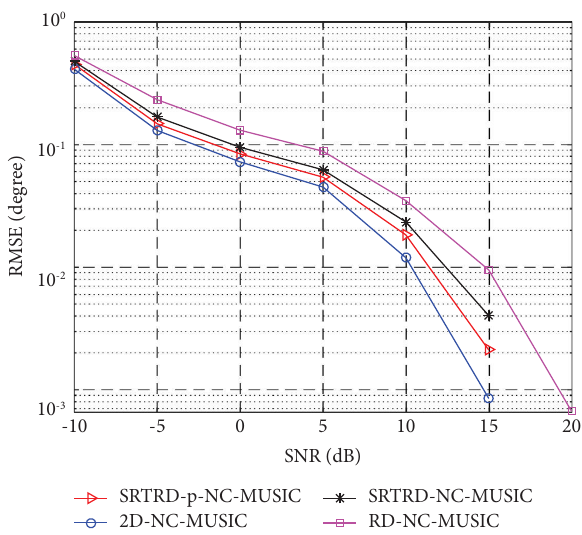
Figure 6: Performance comparison with diferent SNRs, L � 500. Figure 7: Performance comparison with a diferent number of snapshots, SNR �